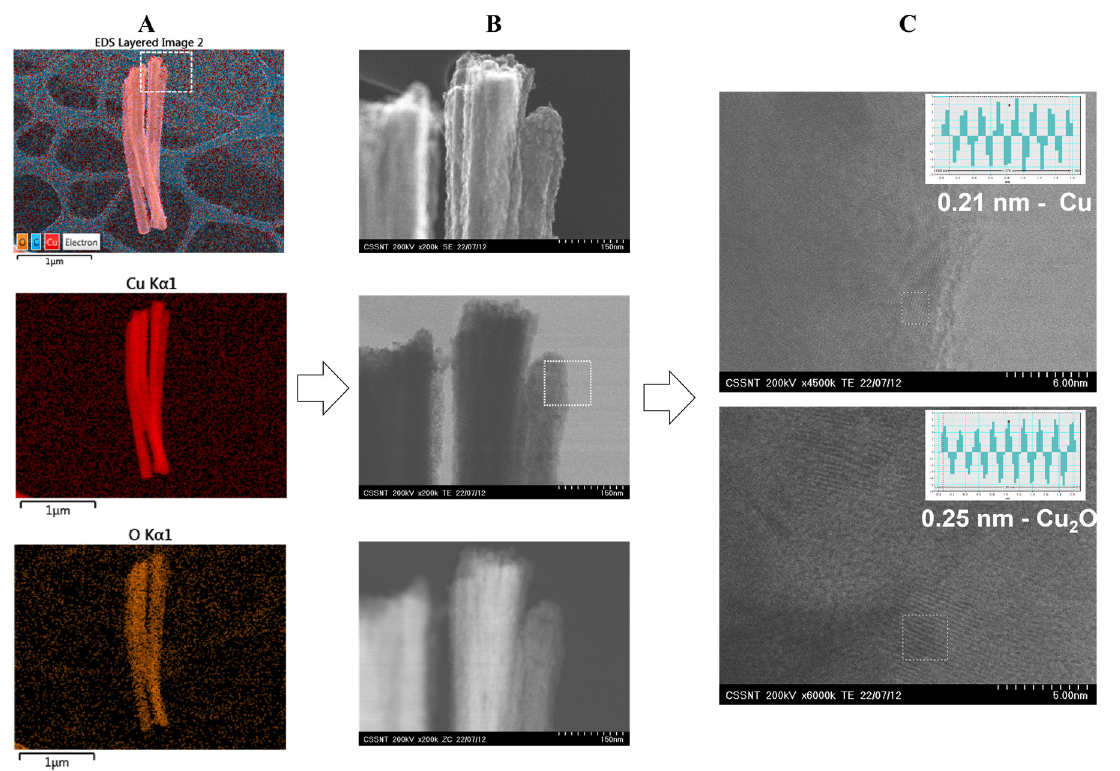
Figure 2. HR-STEM micrographs on CuNCs: ( A ) EDX elemental analysis; ( B ) SEM, TEM, and ZC investigations; and ( C ) interplanar spacing of 0.21 and 0.25 nm assigned to Cu and Cu 2 O,